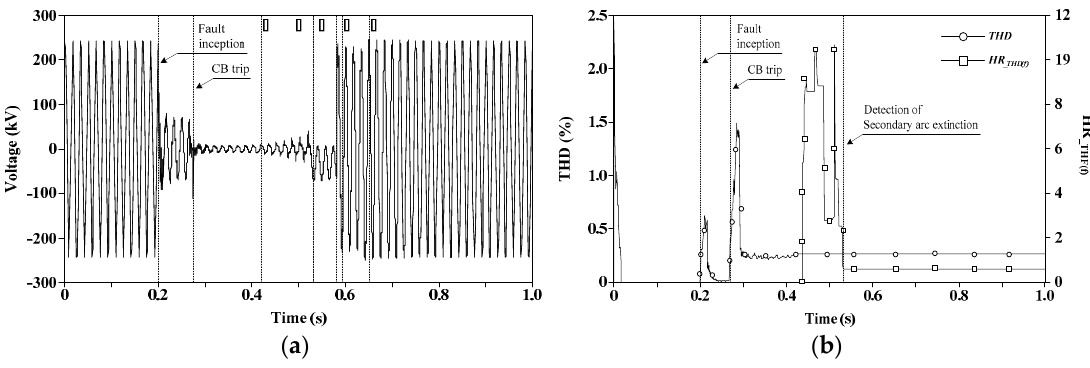
Figure 14. Simulation results for a transient fault: ( a ) faulted-phase voltage; ( b ) THD and HR _THD(f) .